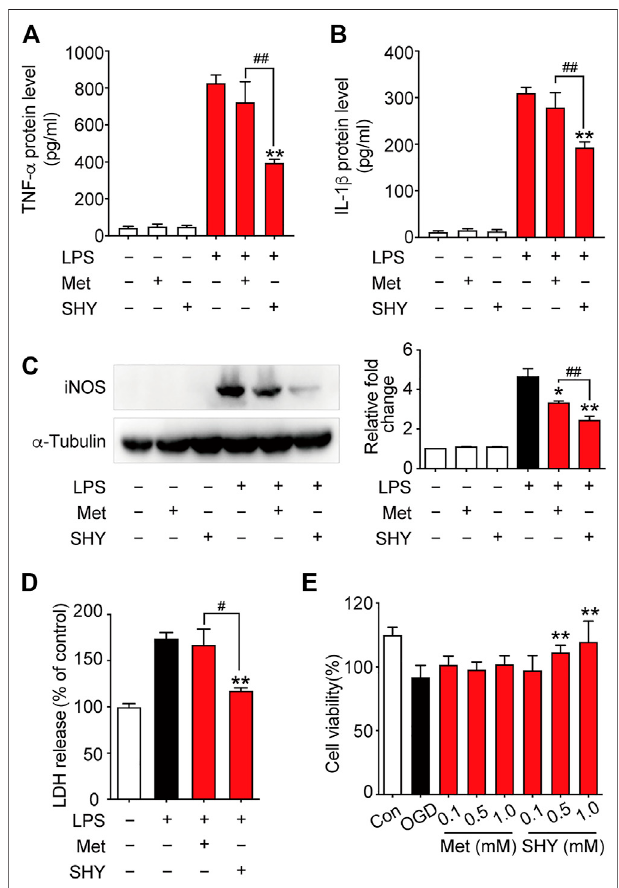
FIGURE 7 | SHY-01 protects against neuronal damage via suppression of microglia activation or direct neuroprotection. BV-2 microglial cells were pre-incubated with SHY-01 (SHY, 1 mM) or metformin hydrochloride (Met, 1 mM) for 1 h followed with LPS (200 ng/ml) treatment. Supernatants of microglia were collected after 24 h for (A) TNF- α and (B) IL-1 β protein level measurement with ELISA. Data were presented as mean ± SD,